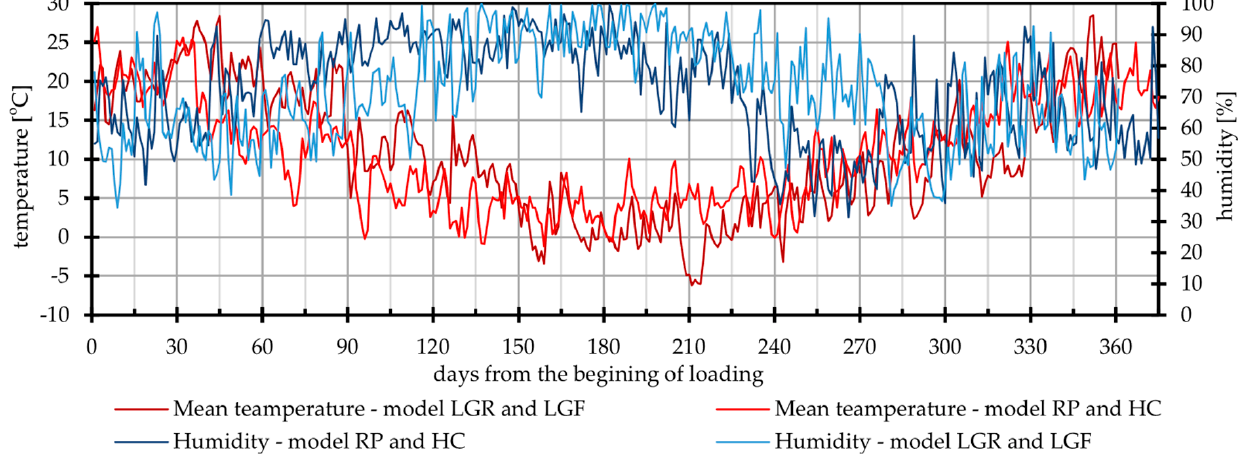
Figure 17. Ambient temperature and humidity during the load period.